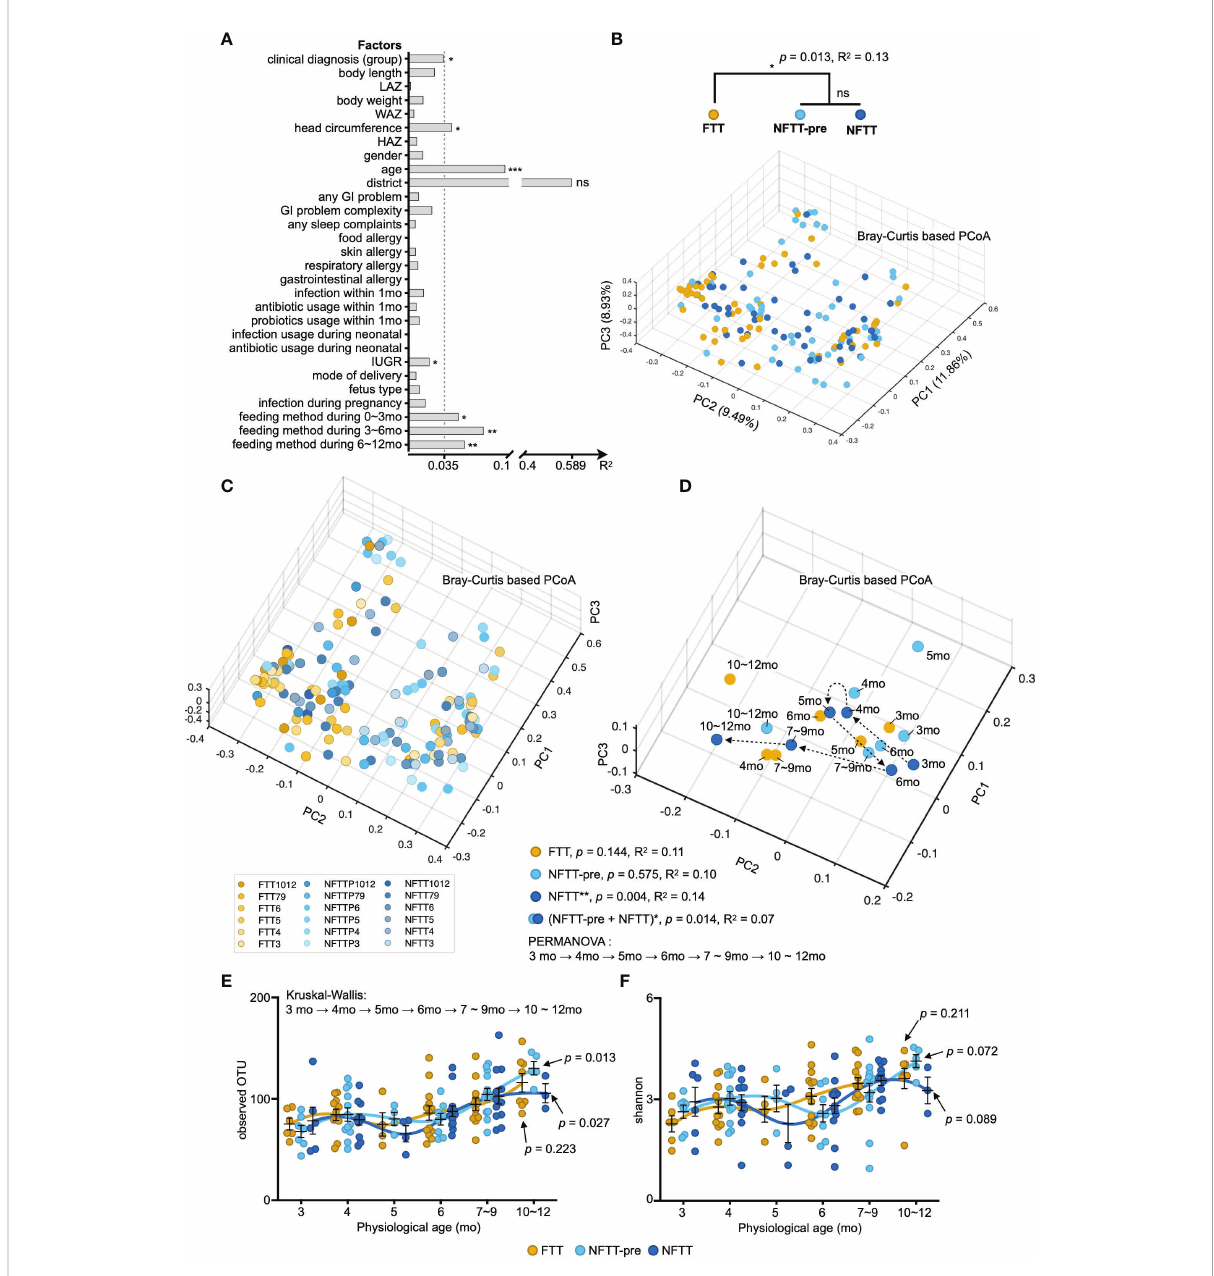
FIGURE 2 Multi-factorial impacts and disorganized development of gut microbiota in FTT. (A) Bars indicate the amount of effect size (R 2 ) of each host factor on infant gut microbiota variations by EnvFit (vegan). Factors are roughly classi fi ed according to our metadata (Table S1), and the factors with signi fi cant effects are asterisked (FDR adjusted p value, * p < 0.05, ** p < 0.01 and *** p < 0.001). (B) Three-dimensional diagram of principal component analysis (PCoA) based on OTU-level Bray – Curtis distance. Plots of each sample were dyed according to their clinical de fi nition (group B) and chronological age (C) . (D) Each centroid indicates the cohort at a speci fi c chronological age and is plotted on a PCoA space. Arrows indicate the temporal progression of microbiota recon fi guration in infants with chronological age. (E, F) Selected alpha diversity, observed OTU (E) , and Shannon (F) in the FTT, NFTT-pre, and NFTT groups. Mean values ± SEM are plotted. Kruskal-Wallis test with Benjamin- Holmes false discovery rate (FDR) correction. ns, no signi fi